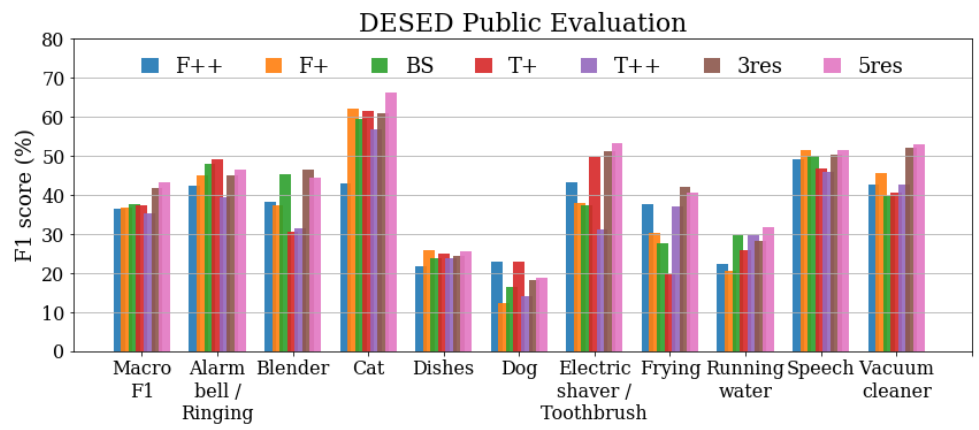
Figure 2. F 1 scores of single-resolution systems ( F ++ , F + , BS , T + , T ++ ) and multiresolution systems ( 3res , 5res ) over DESED Public Evaluation set. “Macro F1” shows average score over 10 target categories. Best viewed in